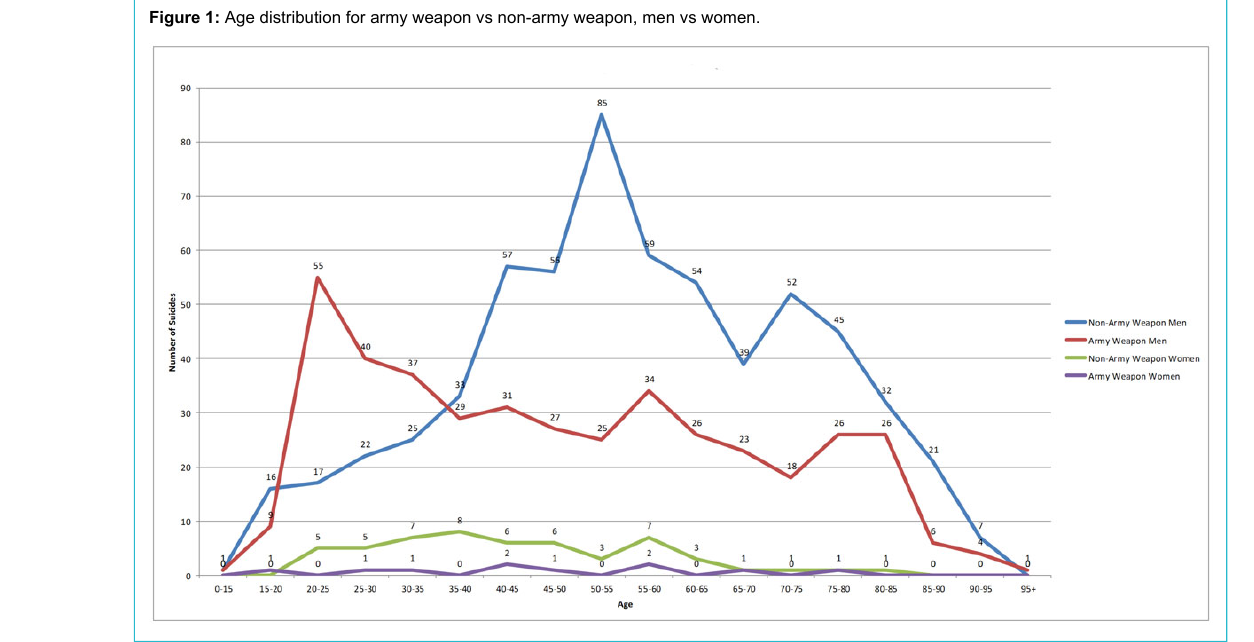
Figure 1: Age distribution for army weapon vs non-army weapon, men vs